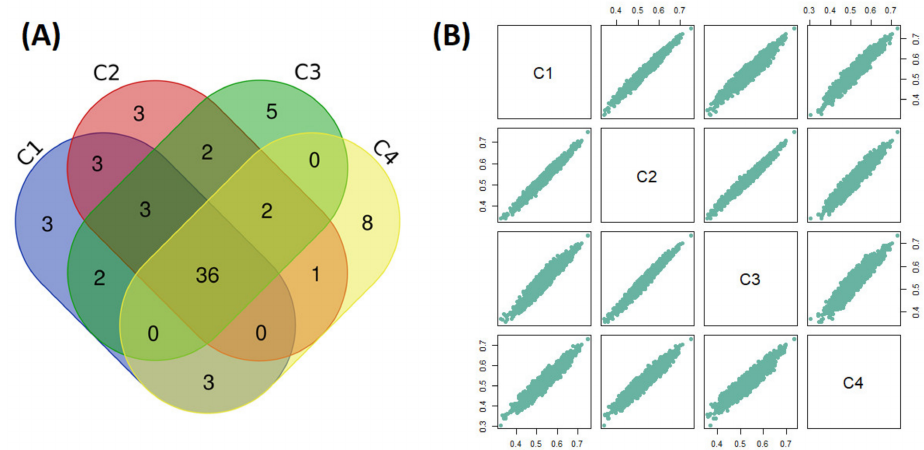
Figure 4. ( A ) Venn diagram of the top 50 drugs obtained for consensus models in each cluster. ( B ) Correlogram of the global desirability values of all drugs across the four clusters. The average correlation coefficient is 0.962